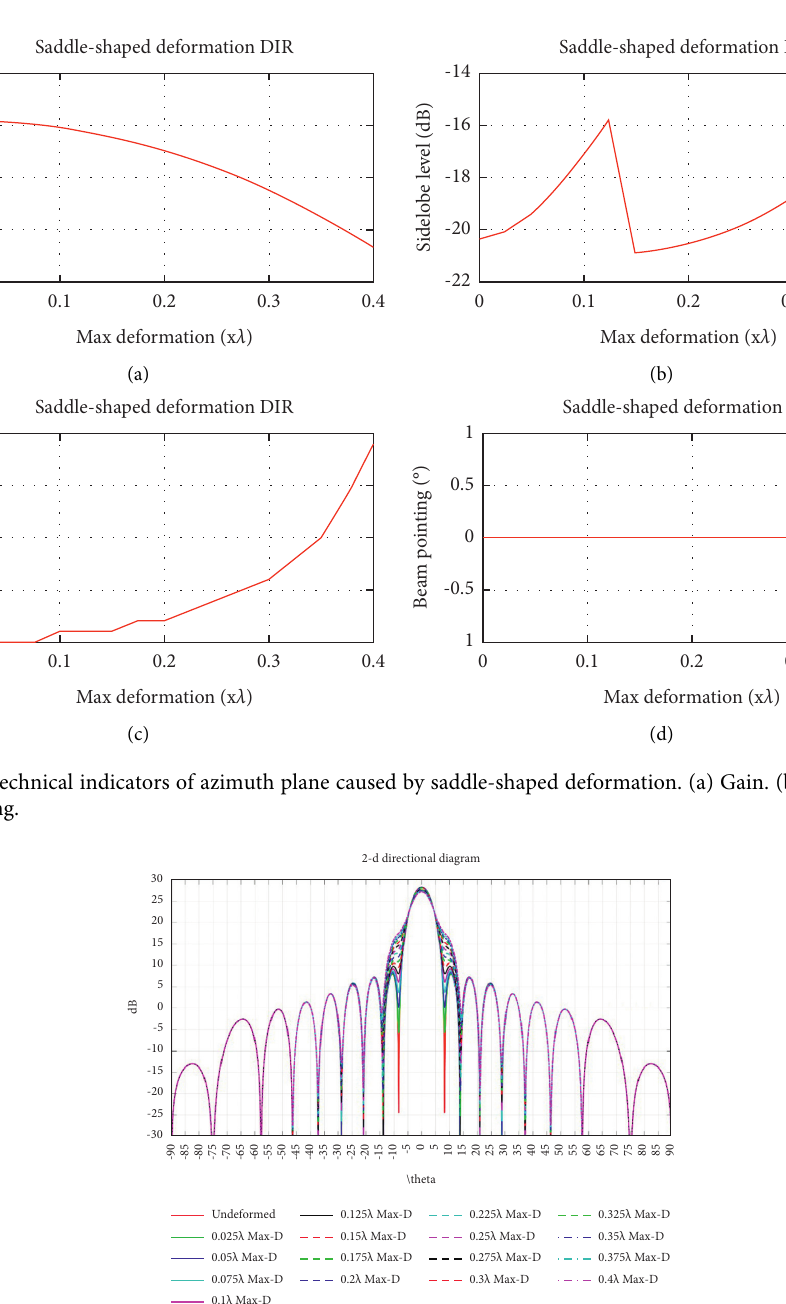
Figure 20: Elevation plane of saddle-shaped deformation.